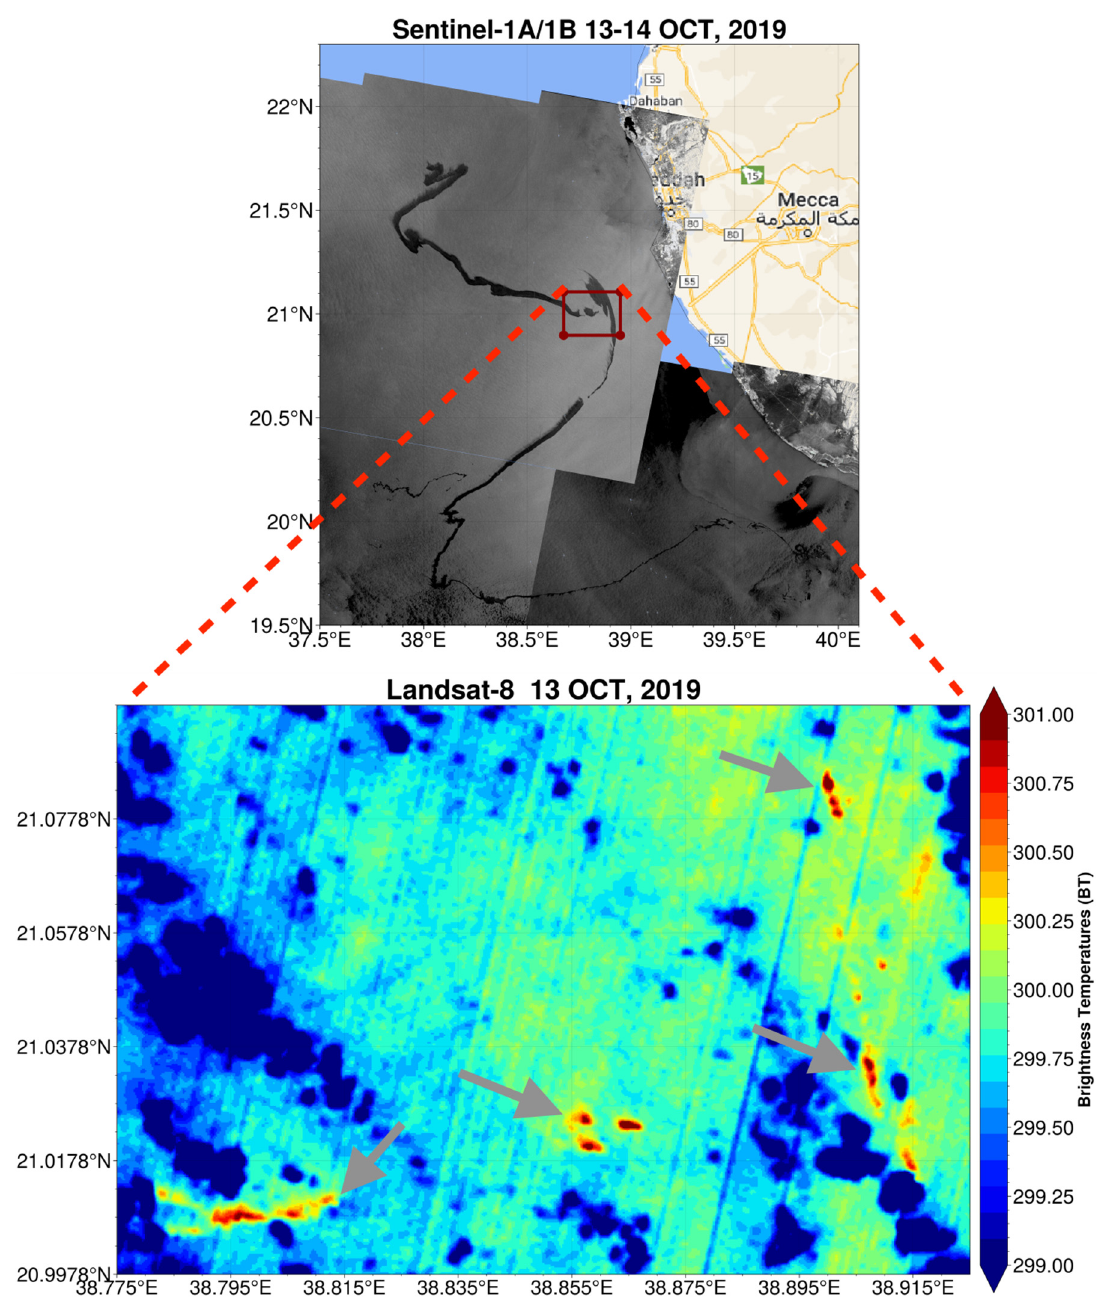
Figure 8. Same as Figure 7, but for the brightness temperature for Lansat ‐ 8 thermal band 10 on 13 October 2019. The gray arrows indicate the oil slicks. 13 October 2019. The gray arrows indicate the oil